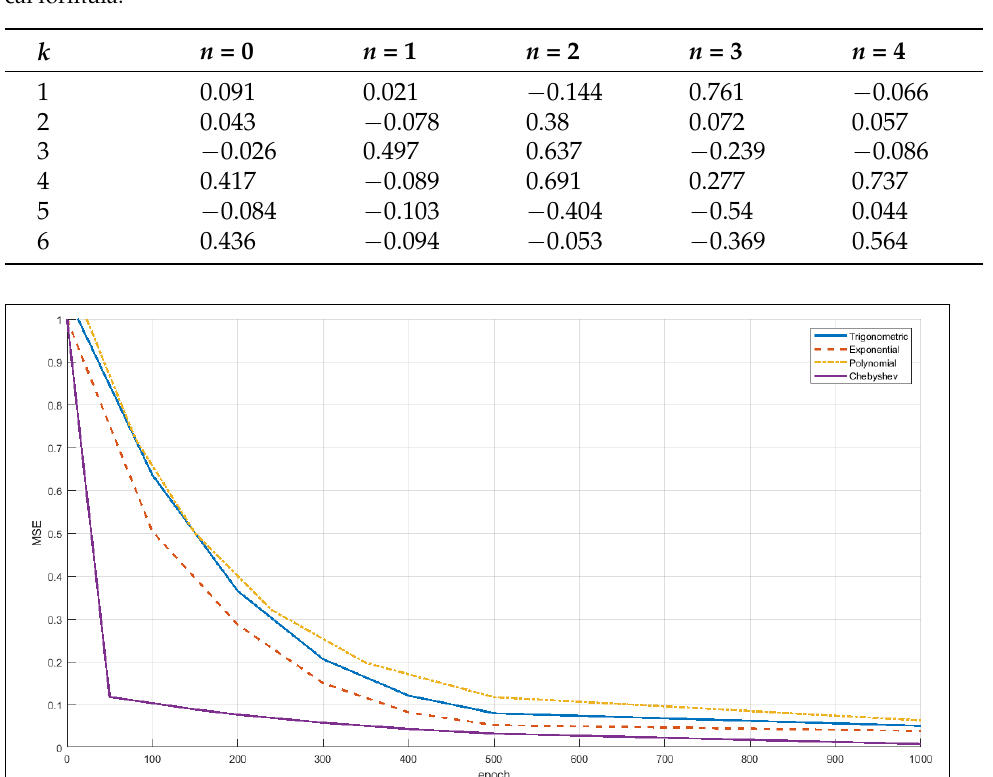
Table 5. Estimated weights ω k ( n ) of the Chebyshev-based FLANN models to be used in the empiri- cal formula.